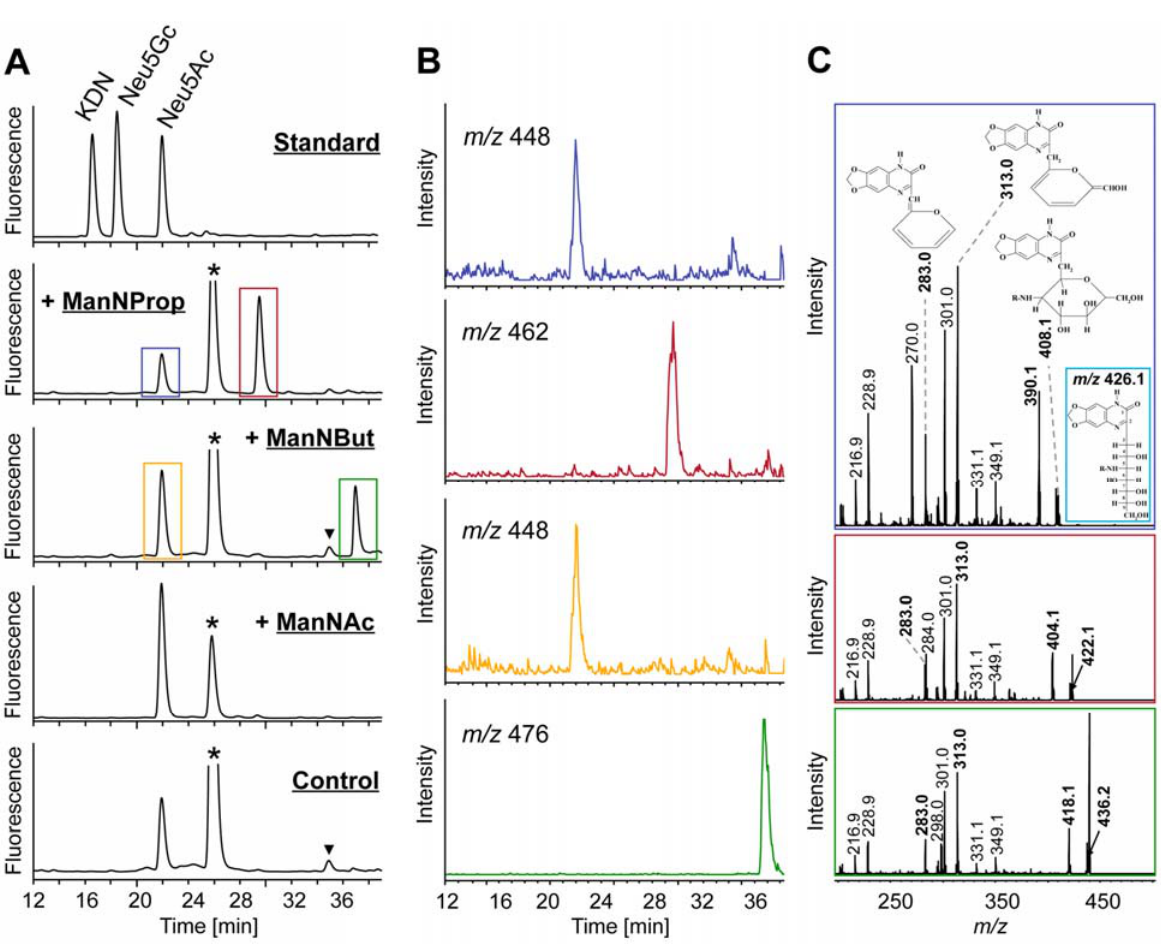
Figure 4. Analysis of sialic acids present in whole cell lysate from HUVECs treated with peracetylated ManNProp, ManNBut, and ManNAc. ( A ) DMB-labeled sialic acid residues were separated by RP-HPLC. For control, HUVECs were not incubated with any sialic acid precursors. ( B ) EIC of sodium adducts ([M+Na] + ) of Neu5Ac ( m/z 448) and Neu5Prop ( m/z 462) as well as Neu5Ac ( m/z 448) and Neu5But ( m/z 476) present in HUVECs incubated with peracetylated ManNProp and ManNBut, respectively. Peaks related to DMB reagent are labeled with an asterisk (*) and those related to further unidentified impurities are marked with a triangle ( ▼ ). ( C ) ESI-MS/MS analyses of Neu5Ac (upper profile), Neu5Prop (central profile) and Neu5But (lower profile) are registered as proton adducts ([M+H] + ). For fragmentation analyses, respective parent ions generated after loss of water were selected. Annotation of fragment ions was performed according to the fragmentation pathway of DMB-labeled sialic acids proposed by Manzi and co-workers [12] with monoisotopic masses of respective fragment ions printed in bold. Corresponding structures of generated fragments are given exemplarily in the upper profile. For the structure of Neu5Ac ( m/z 426.1) prior to loss of water see